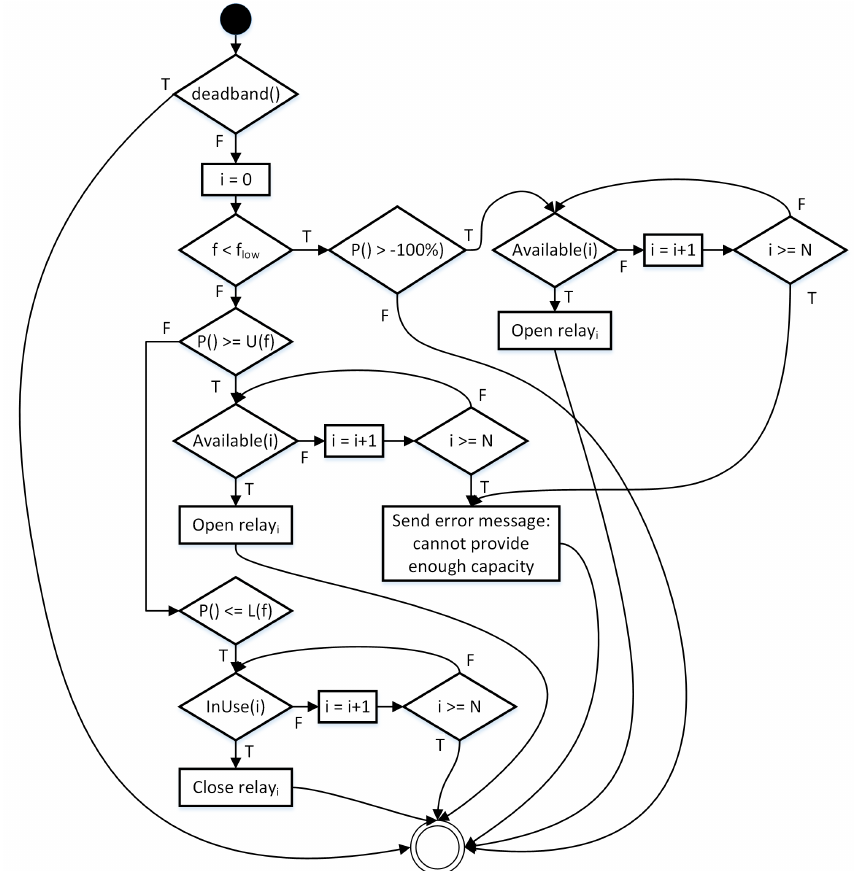
Figure 8. Aggregation of relay-connected distributed energy resources, presented by a UML activity